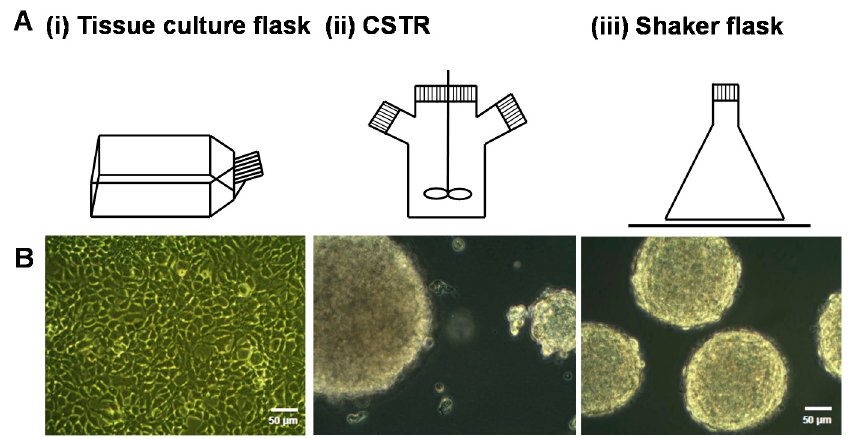
Figure 1. ( A ) Schematic of different bioreactors used to culture the HEK-293 cells expressing serglycin including ( i ) tissue culture flasks, ( ii ) continuously stirred tank reactors (CSTR), and ( iii ) shaker flasks; and ( B ) phase contrast images of cells after three days of culture in the different bioreactor conditions. The scale bar represents 50 μ m.